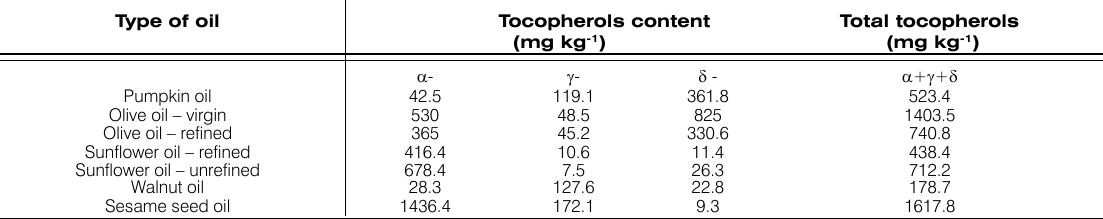
Table 4. Tocopherols content of several vegetal oils, extracted with Porapak Q SPE cartridges and GC analysis Type of